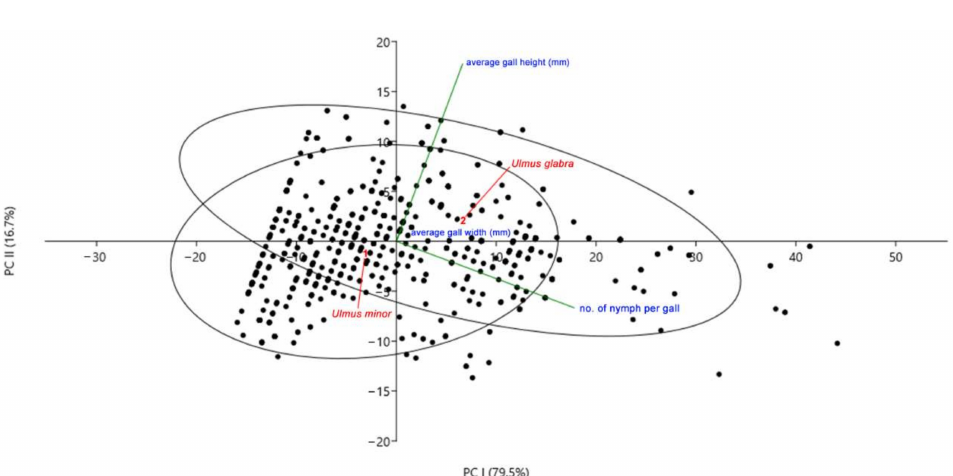
Figure 3. Principal component analysis (PCA) of the gall height and width, number of aphids per gall, and tree